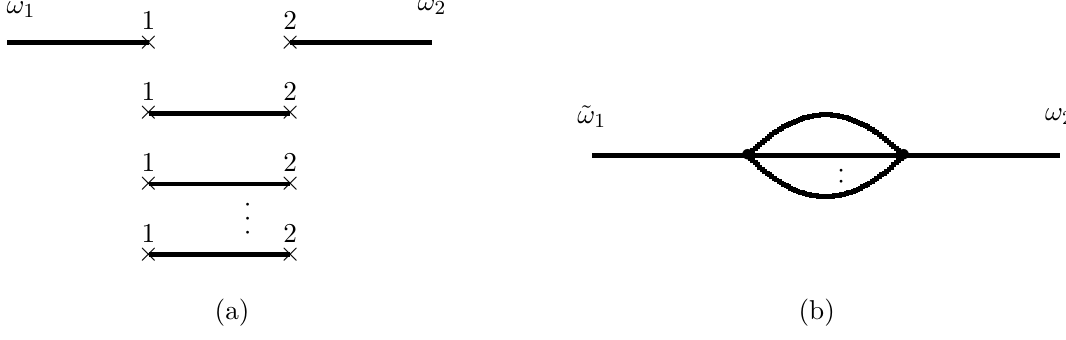
Figure 14 . (a) A set of Feynman diagrams in open closed string field theory that can be part of the leading 2-instanton contribution to the closed string 2-point function. (b) The same Feynman diagram represented in the closed string effective field